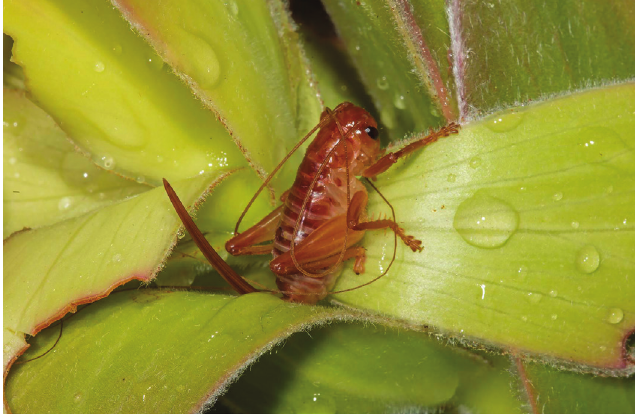
Fig. 2. Glomeremus sp. 2. From the mountains of the southwestern Cape Province, South Africa. Body length about